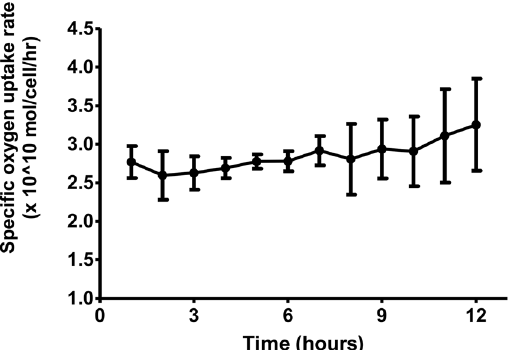
Figure 1. Specific oxygen uptake rate of the alginate-encapsulated hepatocytes in BAL group (n = 5). Gas was supplied right before the reactor, comprised of 95% oxygen and 5% carbon dioxide. Data of dissolved oxygen was measured in real-time before and after the reactor. The flow rate of plasma in the reactor was 250 ml/min. Specific oxygen uptake rate decreased slightly during the first hour of circulation then increased after 7 hours onward, signifying that the hepatocytes remained vigorous activity during the 12-hour treatment